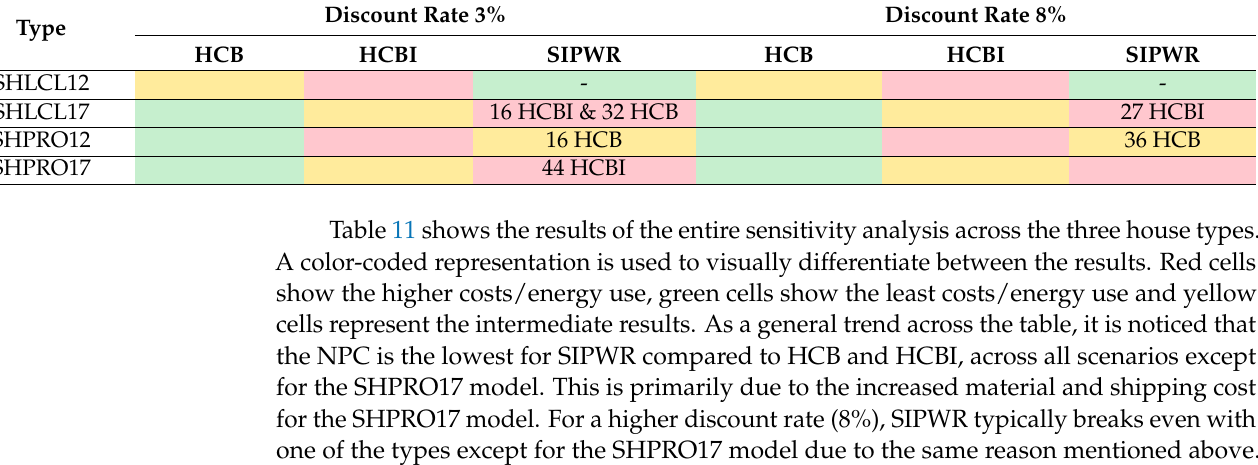
Table 10. Comparison of LCC and breakeven points across the Hollow Core Block (HCB), Hollow Core Block-Insulated (HCBI) and the Structural Insulated Panel Wall (SIPWR) types for discount rates of 3% and 8%. Type